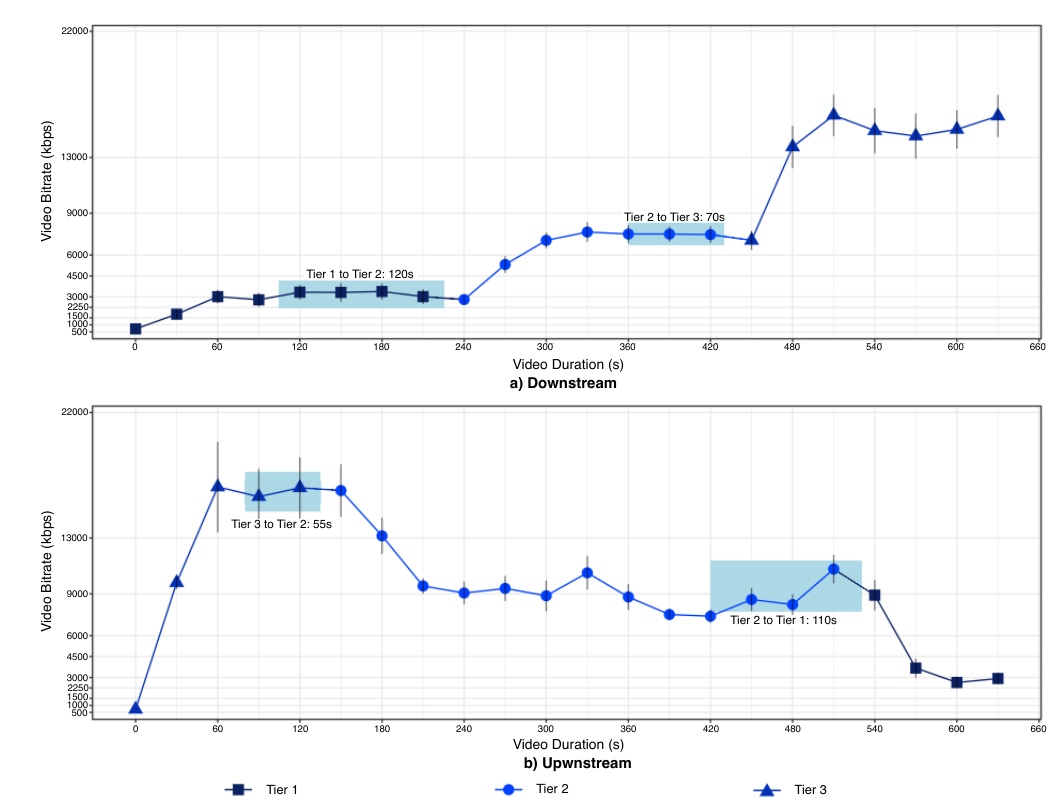
Figure 6. Impact of Live ABR Service Migration Between Tiers of the Proposed Architecture on the Video